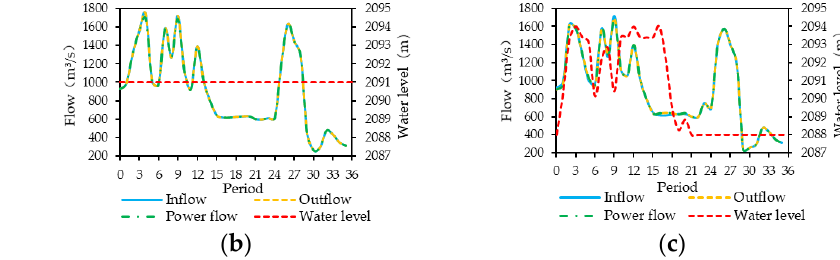
Figure 6. Operation hydrographs of the Yangfanggou Reservoir using ( a ) Scheme 1, ( b ) Scheme 2 and ( c ) Scheme 3.